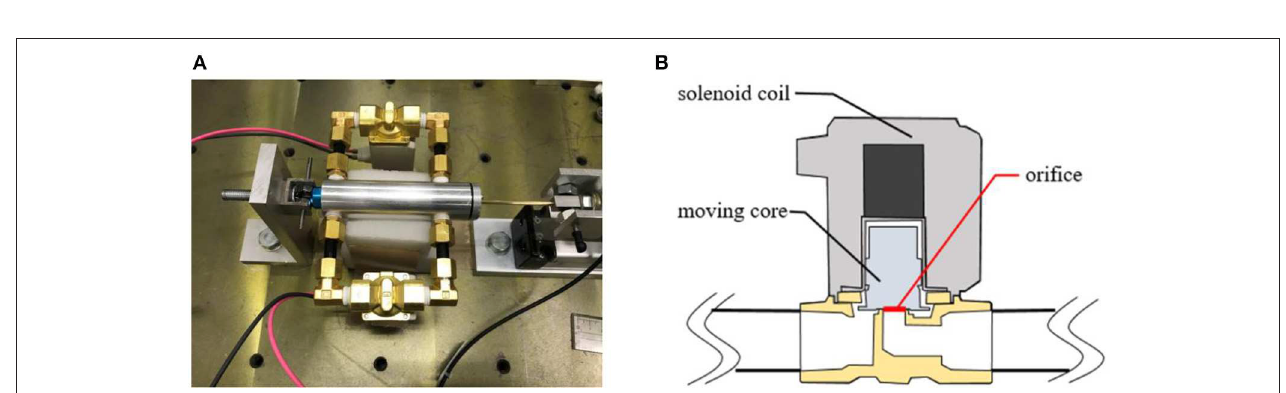
FIGURE 7 | The semi-active control damper. (A) The damper structure. (B) The internal electromagnetic valve.